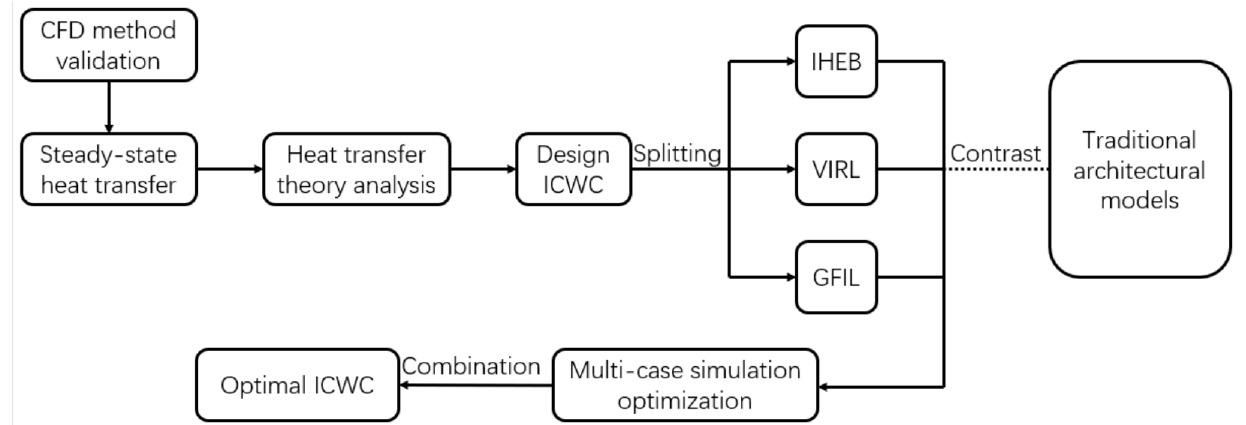
Figure 1. Research methodology flow